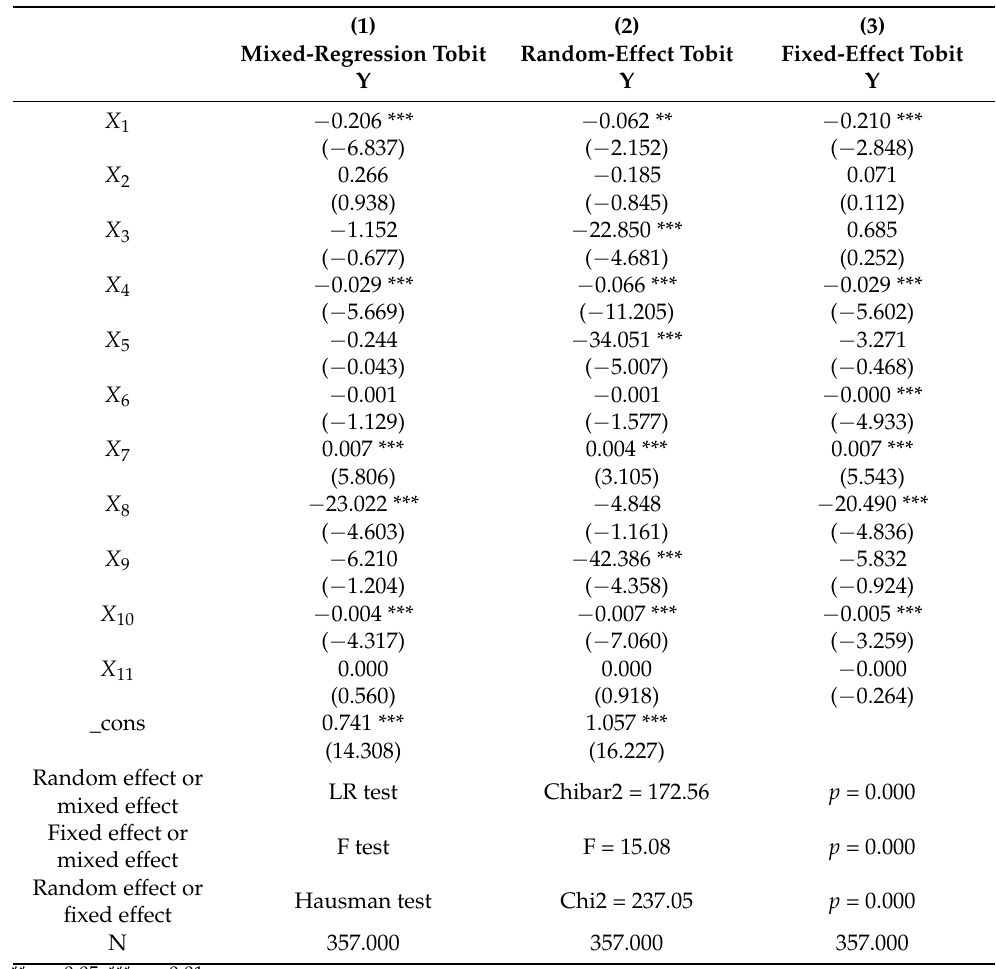
Table 5. Panel regression